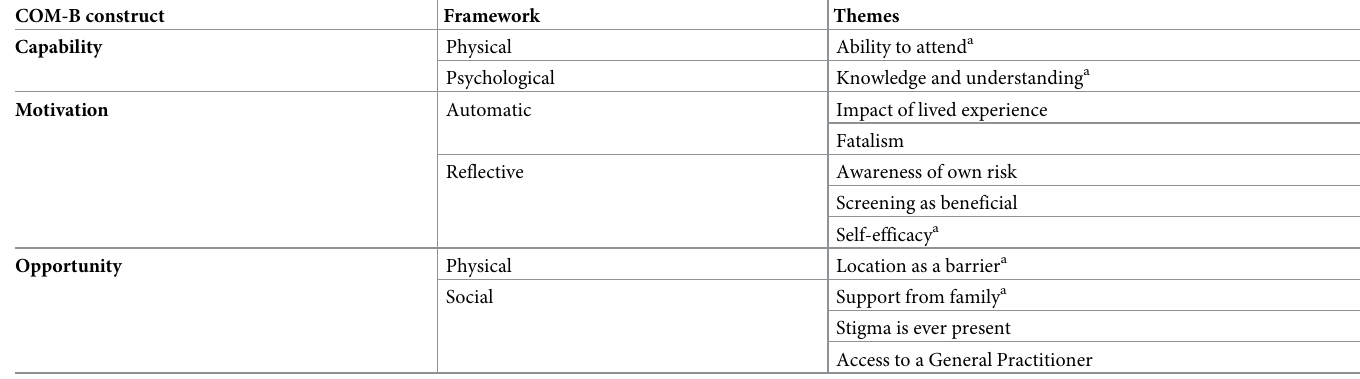
Table 2. Coding framework: Drivers of lung cancer screening participation in Australia using the COM-B (capability, opportunity, motivation-behaviour)